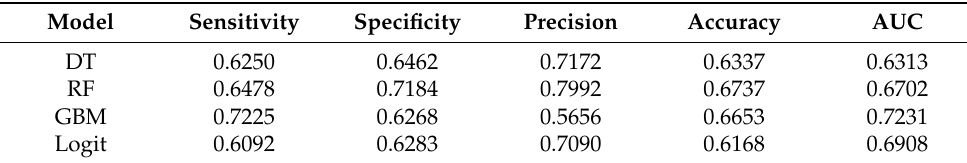
Table 3. Accuracy measures.